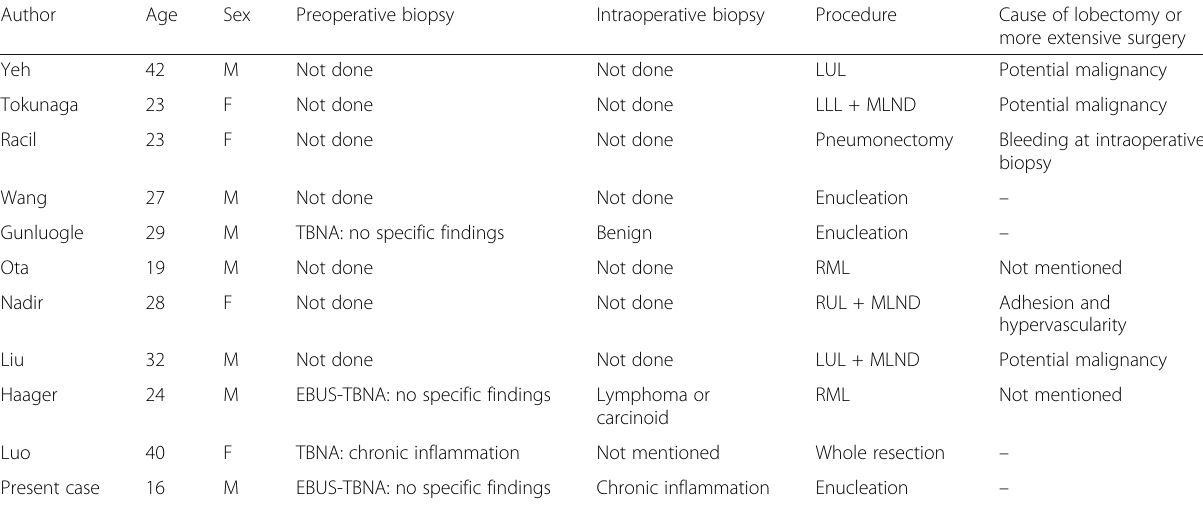
Table 1 Operative procedures and intraoperative biopsies in previously reported cases